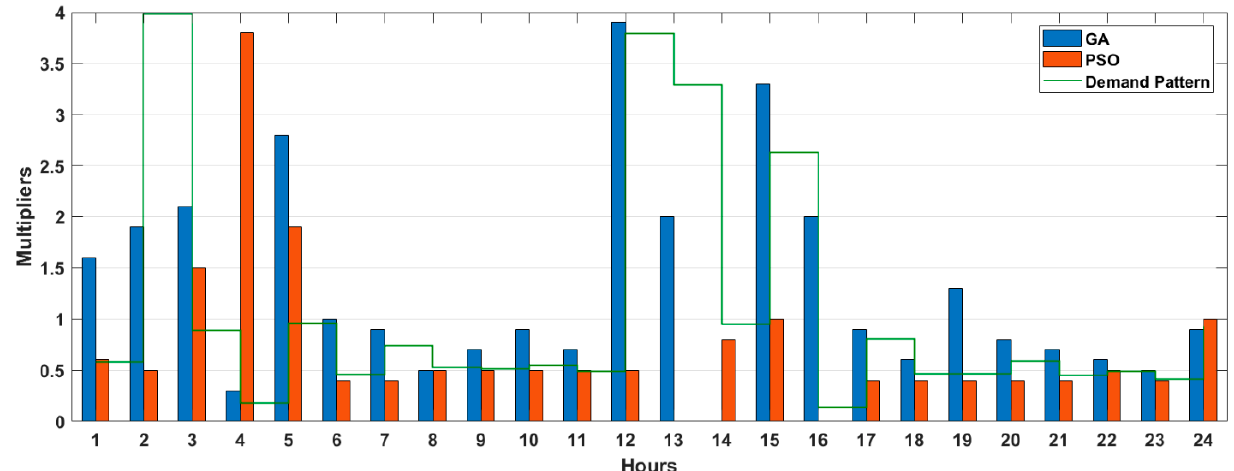
Figure 6. Tank CBS pattern chlorine injection for GA vs. PSO.